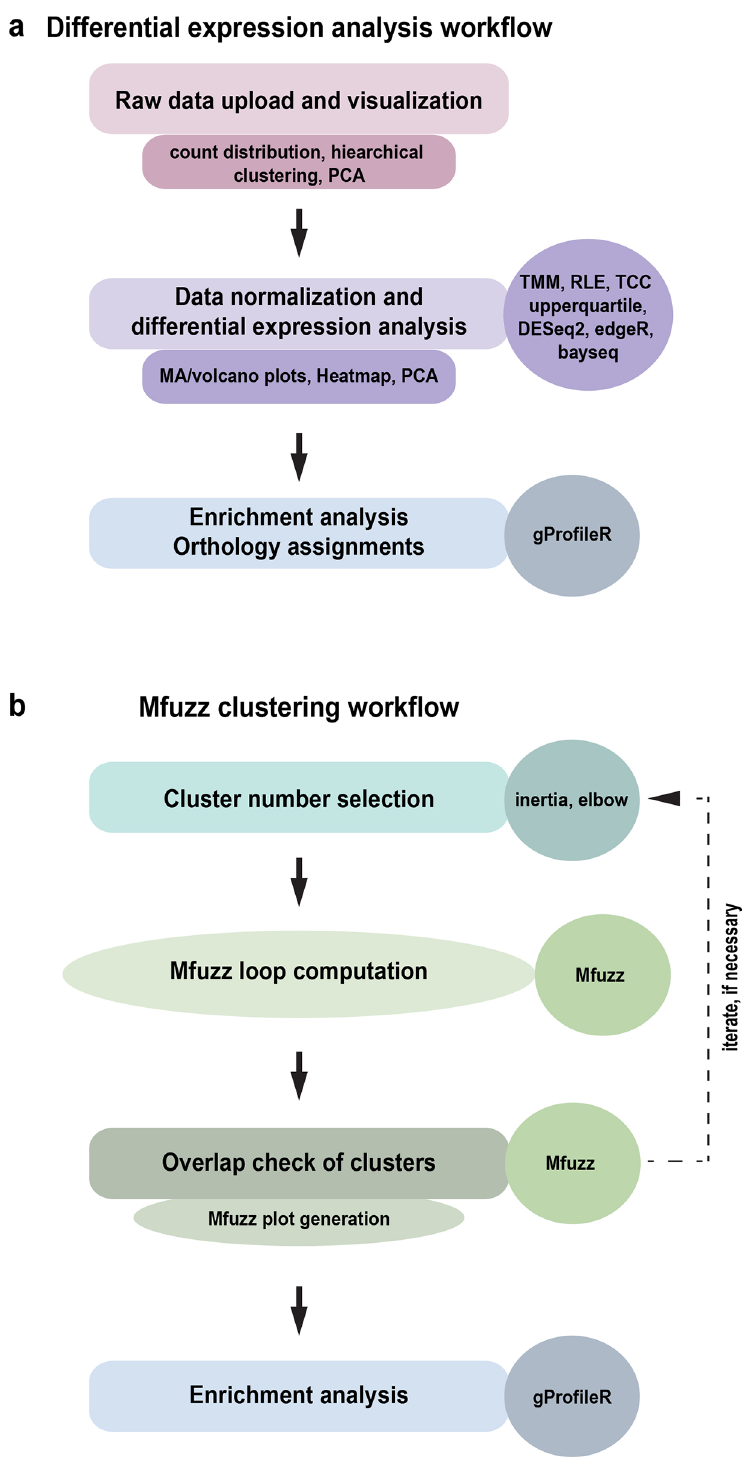
Figure 1. The two RNFuzzyApp analysis pipelines. (a) RNA-seq differential expression analysis workflow with the three main parts: data upload and visualization, data normalization and differential expression analysis, as well as enrichment analysis and the assignment of orthologous genes across species. The types of analyses are shown, as well as the various possible R programs provided for data analysis. (b) Mfuzz workflow for clustering of time-series RNA-seq data. The workflow includes the selection of cluster numbers, checking the overlap of Mfuzz clusters, loop calculations of Mfuzz, Mfuzz plot generation, as well as enrichment analysis of Mfuzz